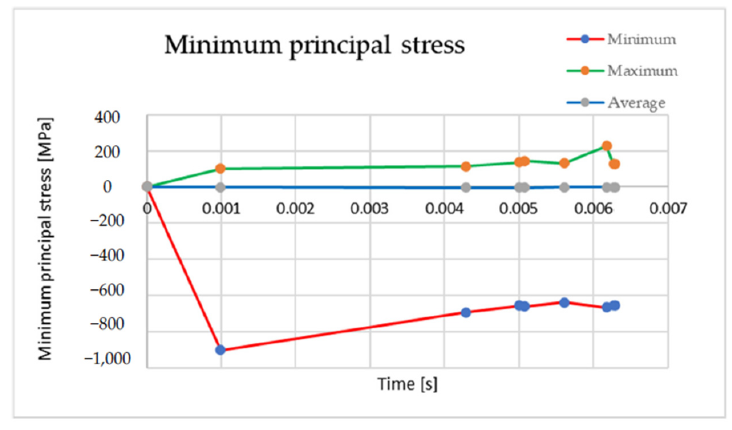
Figure 16. Diagram of Minimum Principal Stress. Table 9. Minimum principal stress.